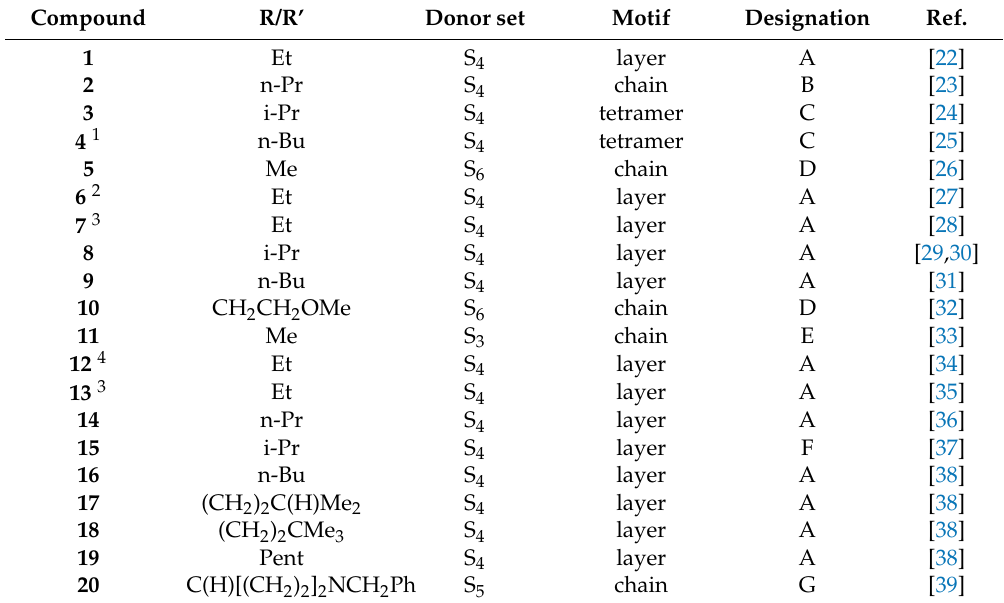
Table 1. Summary of the general features of M(S 2 COR) 2 , M = zinc ( 1 – 4 ), cadmium ( 5 – 10 ), and mercury ( 11 – 20 ),